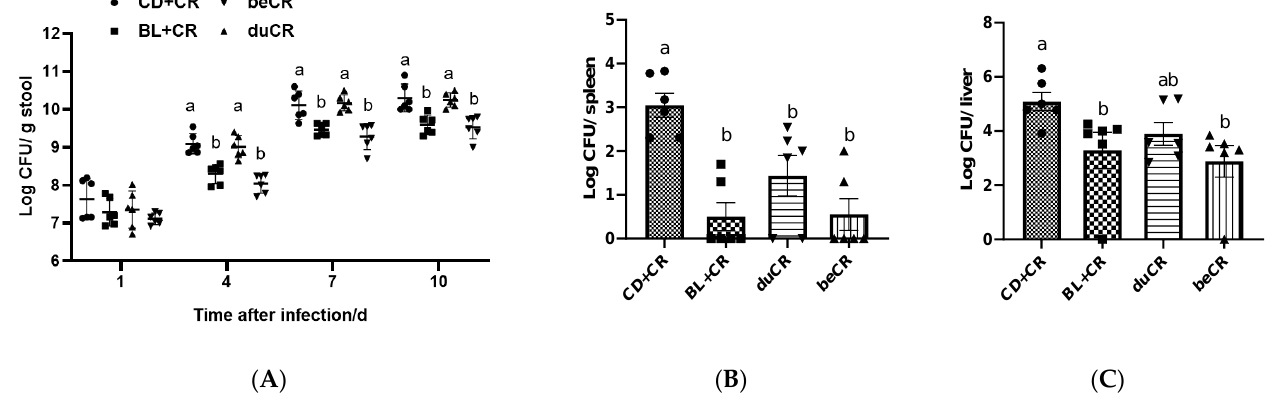
Figure 4. Effect of the beCR and duCR intervention on CR colonization. ( A ) Number of CR in feces on day 1, 4, 7, and 10 p.i. ( B ) Number of CR in spleen on day 10 p.i. ( C ) Quantification of CR in liver on day 10 p.i. The a, b means in the same bar without a common letter differ at p < 0.05.